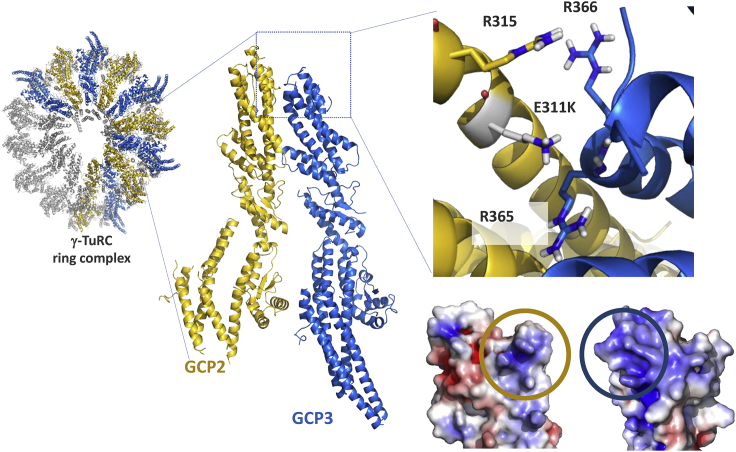
Computational modeling of the E311K mutationThe γ-TuRC ring complex contains five repeating units of GCP2 (gold cartoon) and GCP3 (marine cartoon) complex (pdb id: 6v6s). The acidic GCP2-E311 is complemented by the basic environment made of three arginine residues (R315 of GCP2, R365, and R366 of GPC3). The indicated charge complementarity will be lost upon E311K mutation. This is depicted by the mutation-induced change in the electrostatic distribution of GCP2, facing GCP3. The interacting surfaces of GCP2 and GCP3 are encircled in gold and marine, respectively.